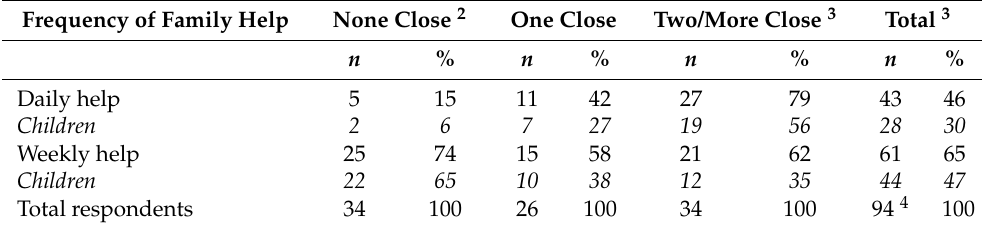
Table 13. Frequency of family help and number of family members living close by who help 1